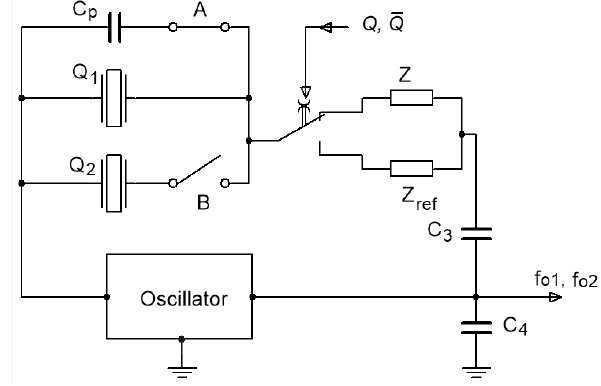
Figure 1. Oscillator’s switching principle.